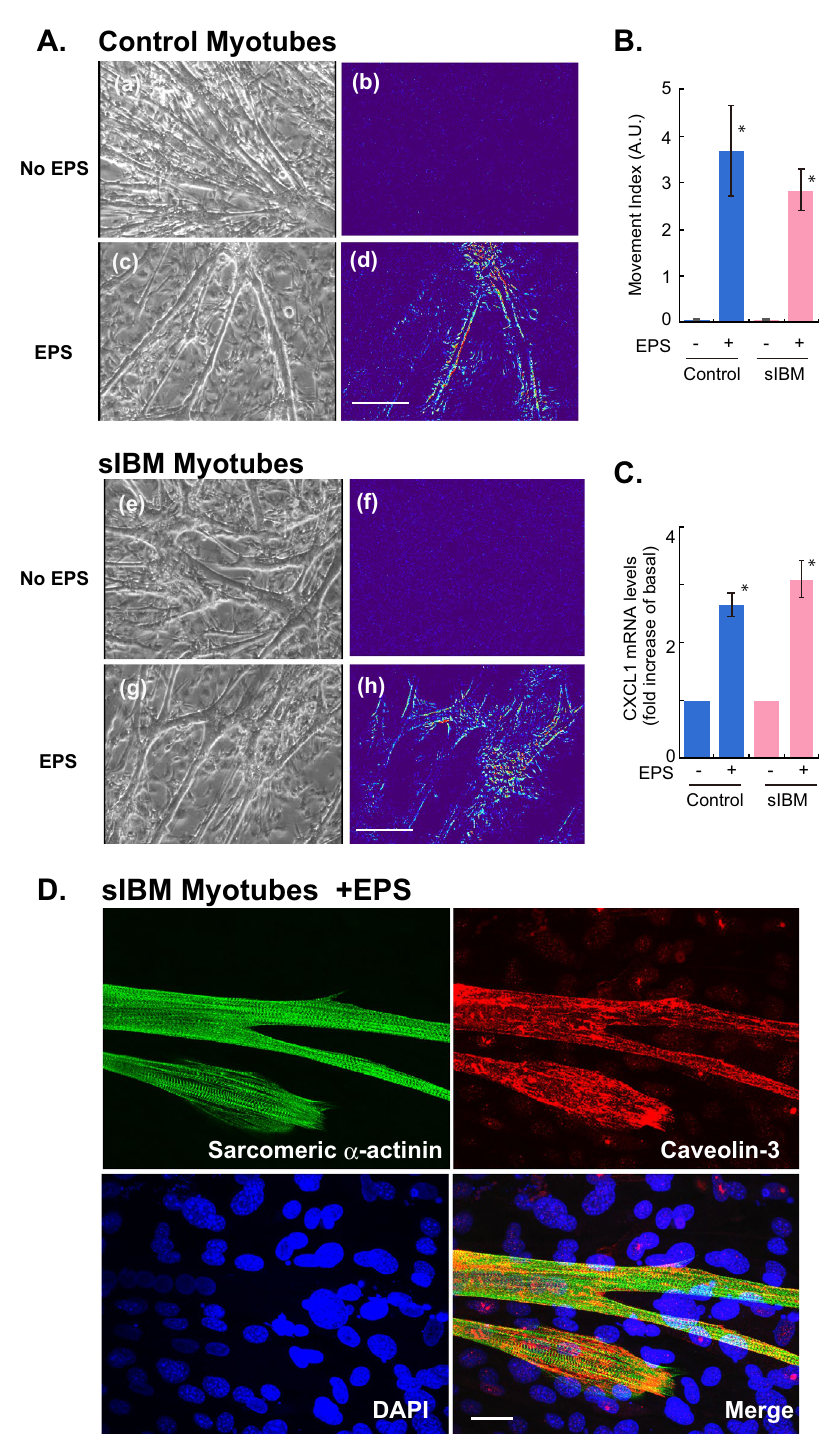
Figure 3. Contractile activity and myokine upregulation in myotubes derived from primary satellite cells of sIBM patients and of healthy subjects. ( A ) By employing the feeder-supported in vitro exercise model, the differentiated myotubes originating from primary satellite cells obtained from biopsy samples of healthy control subjects and sIBM patients were treated with or without EPS at 20 V/25 mm, 1 Hz, 4-ms duration for total of 24 h and their contractility in response to EPS was examined. Images of myotubes were taken during the last 15 min. of the total EPS session. The pseudo-colored differential images ( panels b, d, f and h ), reflecting contractile area and ability, were produced as described in the “Methods” section. The bright-field images of the same area ( panels a, c, e and g ) are also presented. Scale bar = 250 μm. ( B ) The Movement Index was determined as described in the “Methods” section. *Significant effects compared to No-EPS ( n = 3, * p < 0.05). ( C ) Total RNA was extracted and mRNAs for human CXCL1 and RPLP0 were evaluated by real-time PCR analysis. Data were normalized using human RPLP0 transcripts and the values are presented as fold increases as compared with basal (No-EPS treatment) ( n = 3, * p < 0.05). ( D ) After EPS treatment, the sIBM myotubes were fixed for evaluating sarcomere formation status by using anti-sarcomeric-α-actinin ( green ) and anti-Caveolin 3 ( red ) antibodies. DAPI was used for nuclear staining ( blue ). Scale bar = 25 μm. Three independent experiments were performed and representative images are